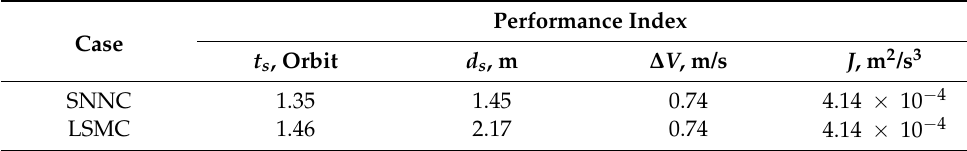
Table 5. Performance indices .